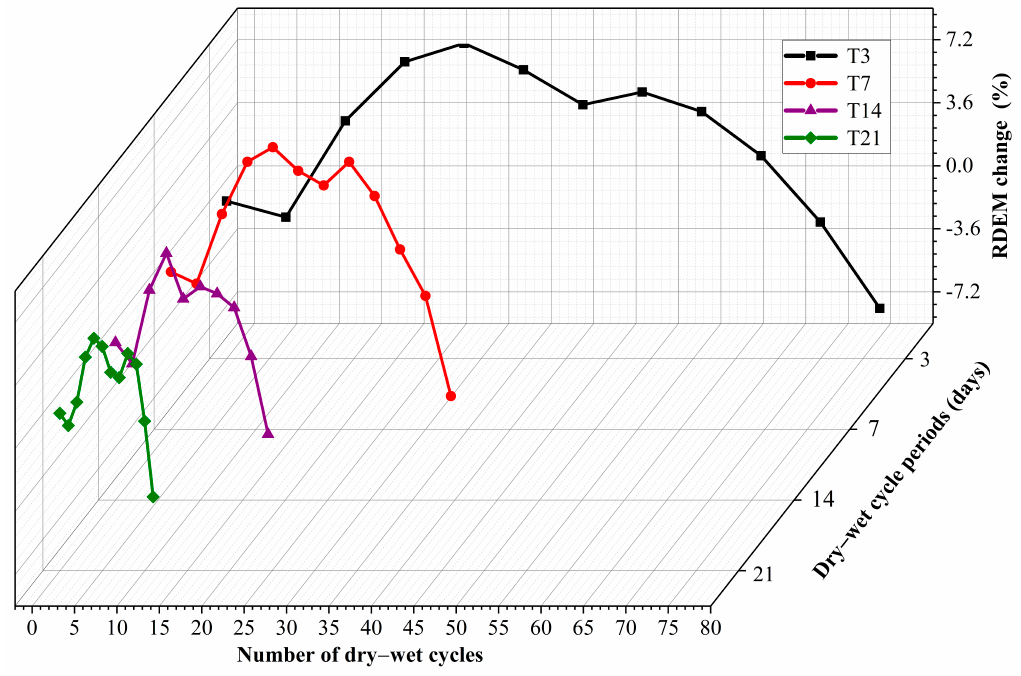
Figure 8. Variation of relative dynamic elastic modulus among different dry-wet cycle